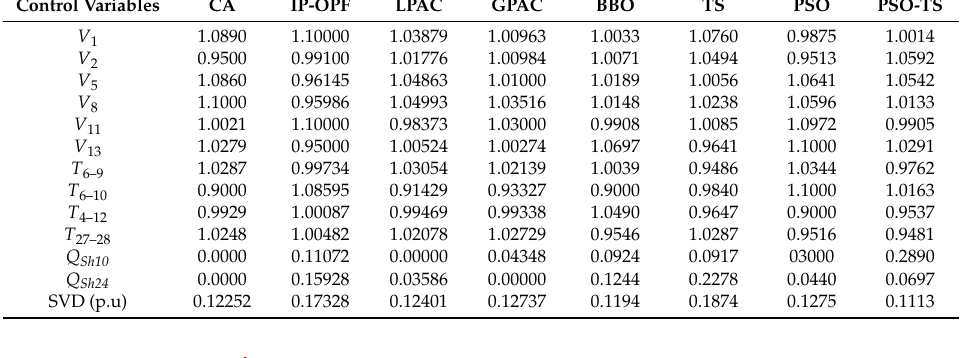
Table 3. Experimental results of TS, PSO and PSO-TS algorithms (Case 1).